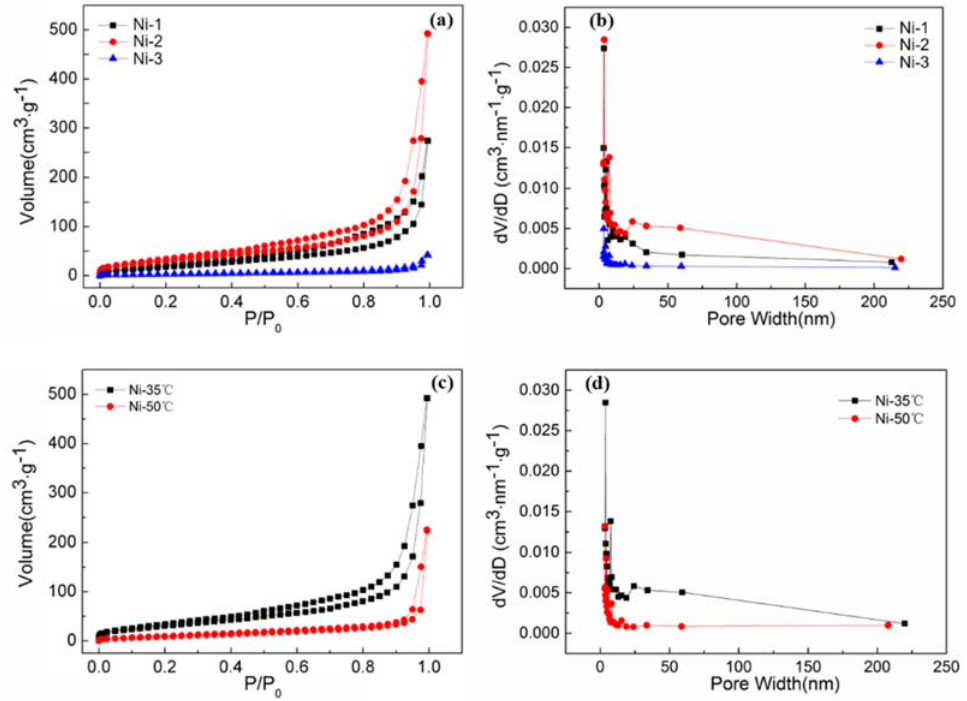
Figure 4. Typical nitrogen adsorption and desorption isotherms and size distribution based on the Barret-Joyner-Halenda (BJH) method for the nanoporous Ni at different electroless plating times ( a , b ) and for Ni-2 at different electroless plating temperatures ( c , d ). Table 1. Comparison of textural characteristics of the nanoporous Ni at different electroless plating conditions determined from nitrogen adsorption-desorption isotherms.